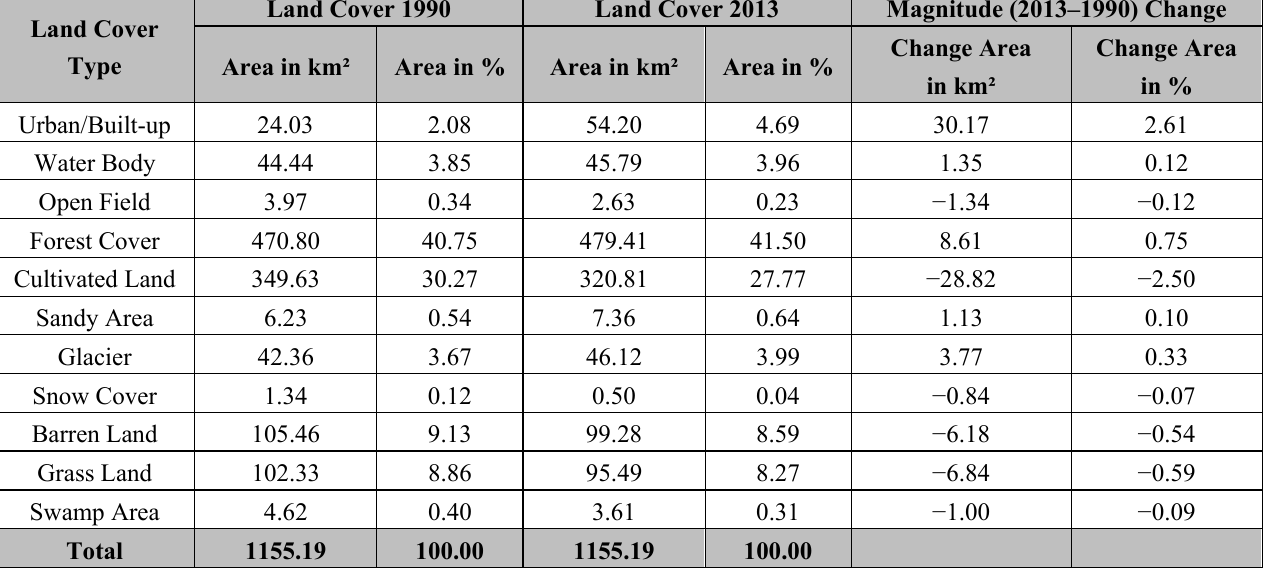
Table 1. Land use/land cover change,